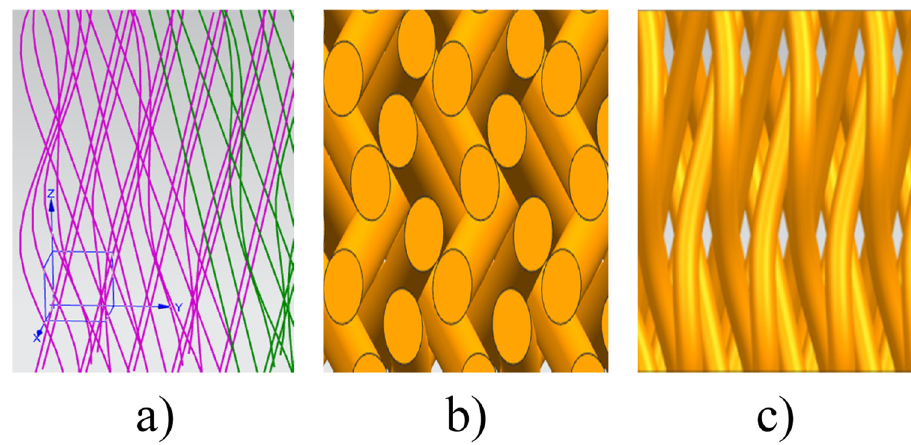
Figure 10: Geometric model of specimen with 15° braided angle: ( a ) yarn track, ( b ) top view, and ( c ) side